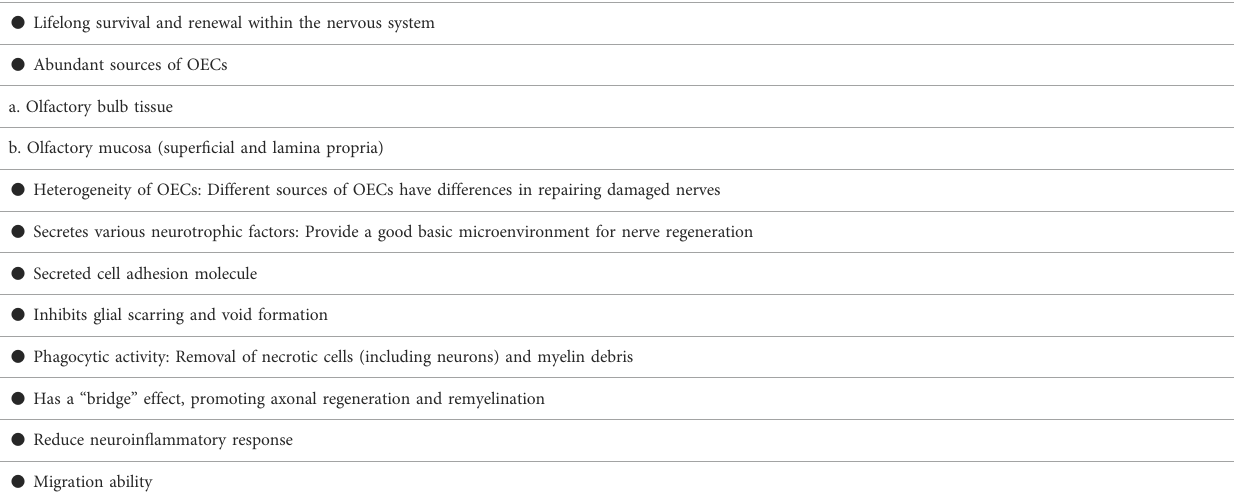
TABLE 1 Biological characteristics of olfactory ensheathing cells